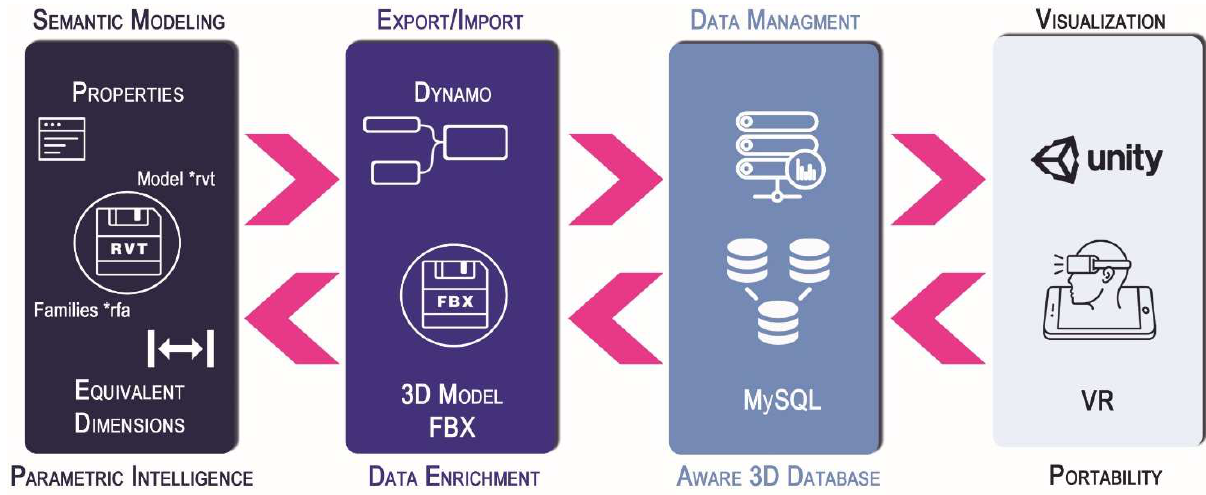
Figure 8. Workflow of method: from semantic modeling to visualization through export and data management